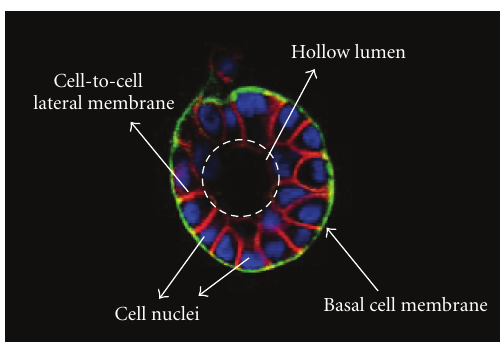
Figure 1: Three-dimensional view of a typical nonmalignant cell line culture. Acinar structures are surrounded by the ECM proteins.